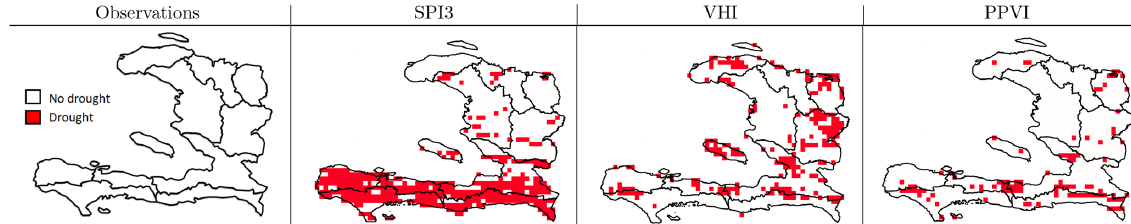
Figure 8. Comparison of the performance of the SPI3, VHI, and PPVI in identifying the areas hit by drought in week 45 of 1995. Departments highlighted in red are the ones in drought according to observations (Table 7); red cells are the ones in drought conditions according to the various indices.